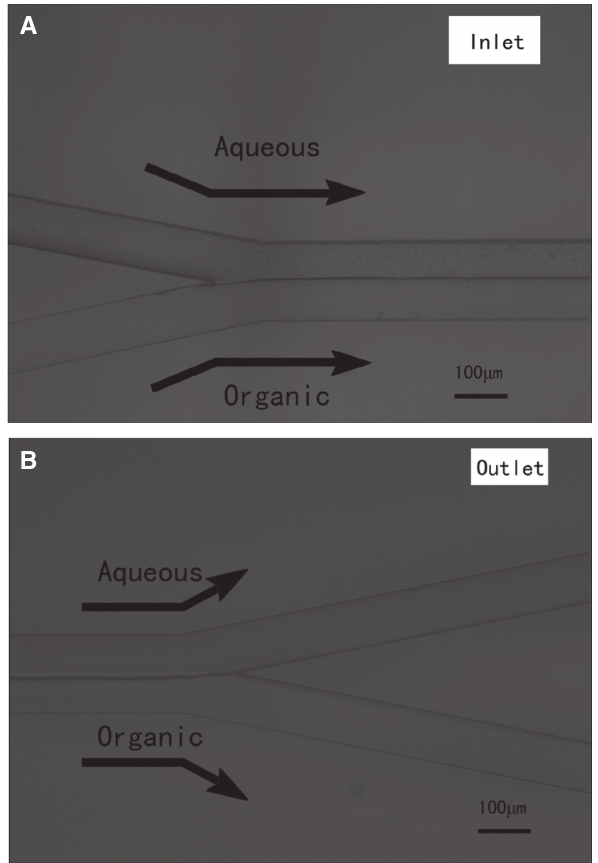
Figure 3 Photos of the merging and diverging of aqueous and oil flows.